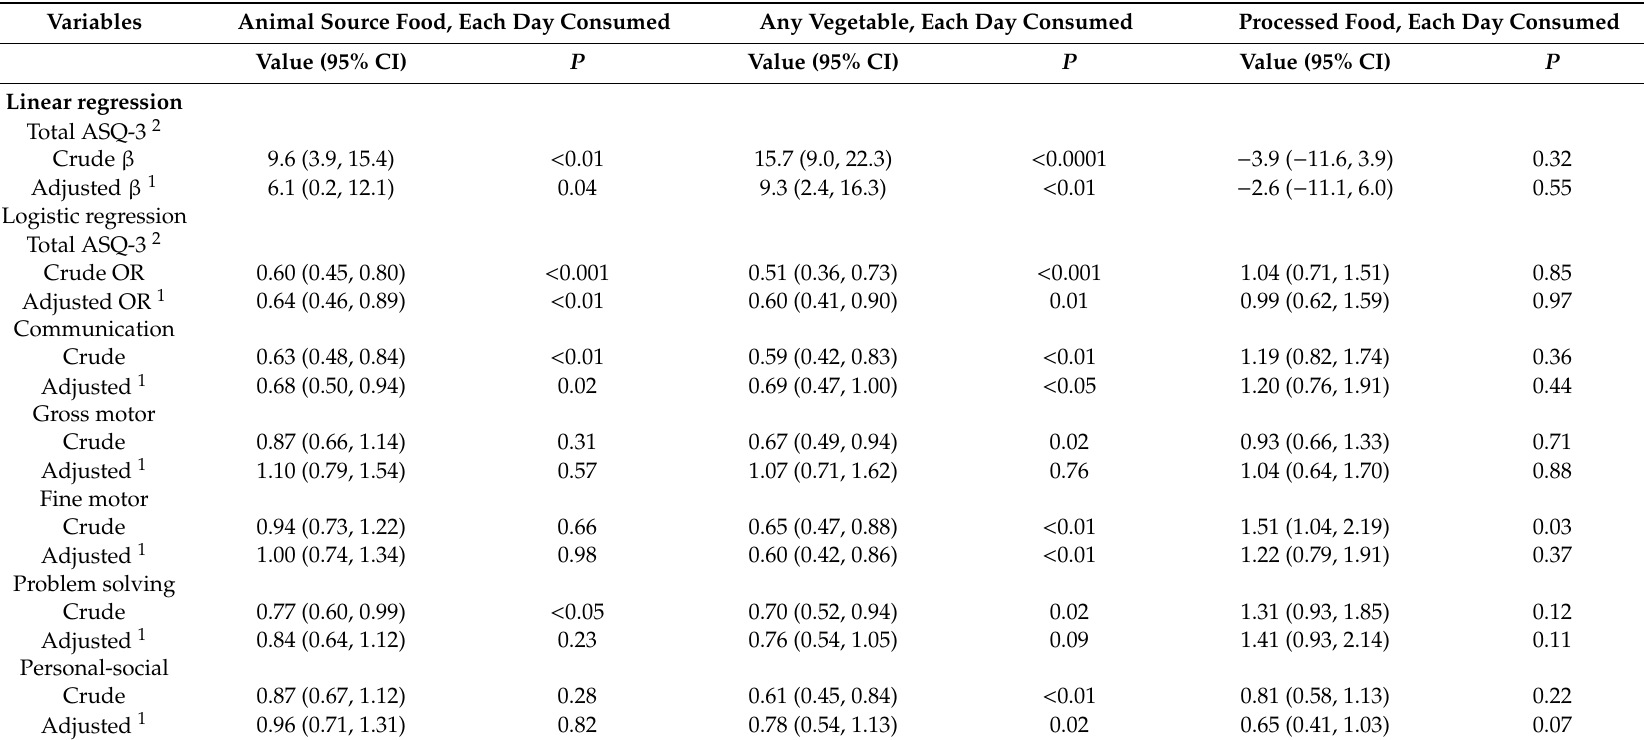
Table 5. Unadjusted and adjusted relationships between diet (number of days of animal source food consumption, vegetable consumption, and processed